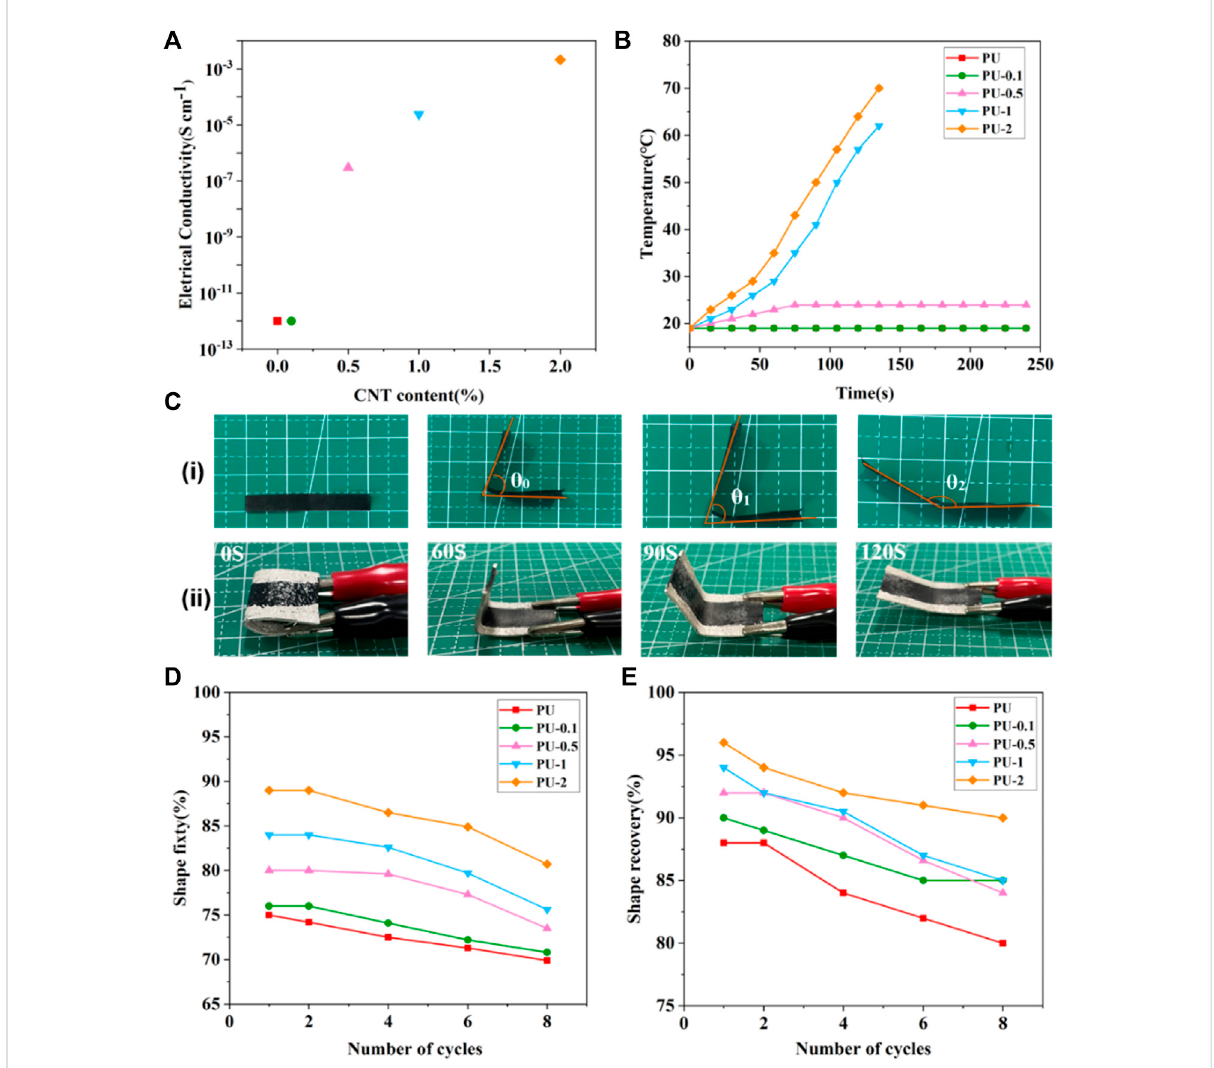
FIGURE 5 (A) Conductivityand (B) temperaturechangesamongSMPU/i-MWCNTcompositesatavoltageof30 eV. (C) Photosof(i)ashapedeformation- recoverycycleand(ii)theshaperecoverybehaviorsofSMPU/i-MWCNTcompositeswith1 wt%i-MWCNTcontentatavoltageof30 eV.Quantitative analysis of the shape memory (D) fi xation and (E) recovery rates over various shape strain-recovery cycles for SMPU/i-MWCNT composites with various i-MWCNT contents at temperatures below 60 ° C.